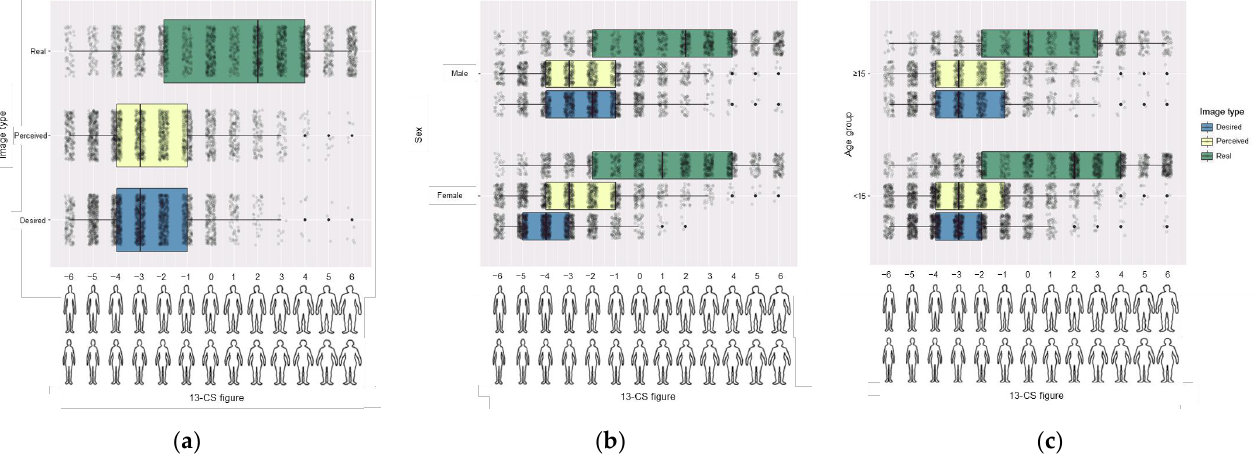
Figure 1. Boxplots of the real, perceived and desired body images according to a 13-Card Scale (13-CS) ( a ) including all the participants; ( b ) stratifying by sex; ( c ) stratifying by age